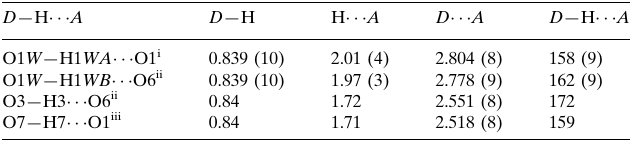
Hydrogen-bond geometry (A˚ , (cid:3)